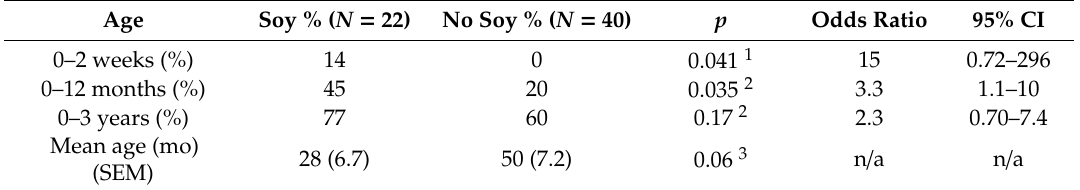
Table 10. Timeframe of allergies in FXS study population as a function of soy-based diet.